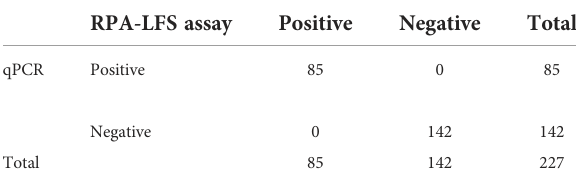
TABLE 3 Prevalence of ITS2 in 227 clinical isolates of C. glabrata with the RPA-LFS and qPCR assays.